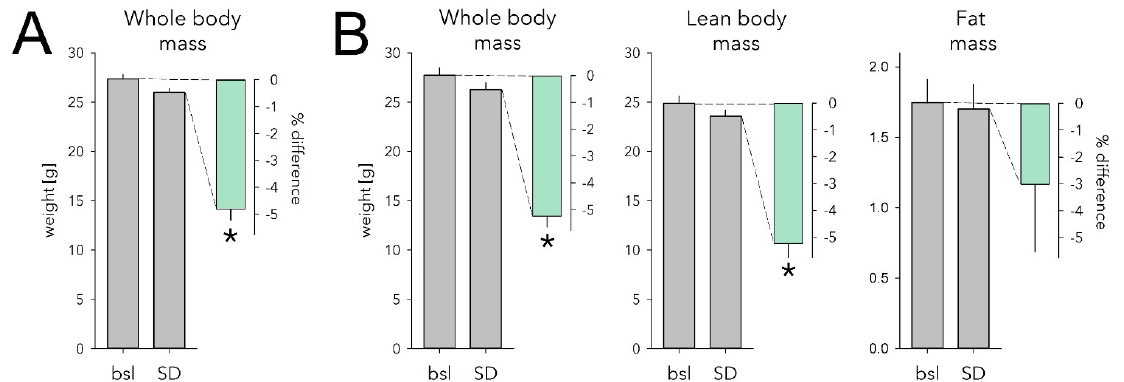
Figure 4. Effect of sleep deprivation (SD) on body weight and body composition. ( A ) SD caused a 4.8% weight loss in mice with ad libitum access to food (mint bar; p = 1.3 × 10 − 5 , paired two-sided t -test, n = 9). Body weight measured after the 6 h SD (grey bar) ending at ZT6 was 1.3 ± 0.1 g lower compared with that reached at this time of day on two preceding baseline days (bsl; grey bar; average of the 2 days). ( B ) Body composition was measured in a separate cohort following the exact same protocol as in A. SD similarly reduced whole body weight in this cohort ( − 1.5 ± 0.1 g, 5.2%; p = 9.6 × 10 − 5 , paired two-sided t -test, n = 6). Lean body mass decreased to the same extent ( − 1.3 ± 0.1 g, 5.2%; p = 3.1 × 10 − 4 ). Fat mass was reduced as well but not significantly so ( − 0.04 ± 0.04 g, 3.0%, p = 0.33). Details as in ( A ). * marks significant SD vs. bsl effects. Note different scale for grams of fat mass. Error bars mark 1 SEM.